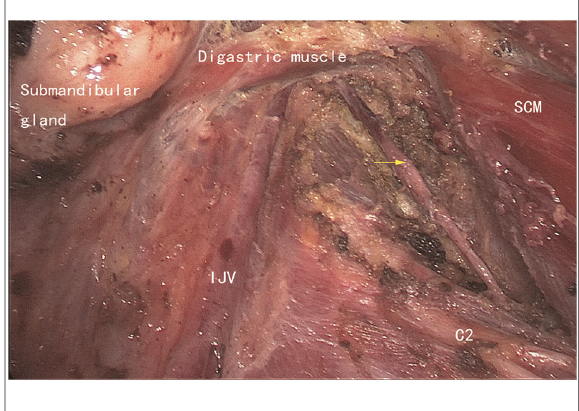
FIGURE 5 The superior boundary (left side). SCM, sternocleidomastoid muscle; IJV, internal jugular vein; C2, the second branch of the cervical plexus; yellow arrow: the accessory